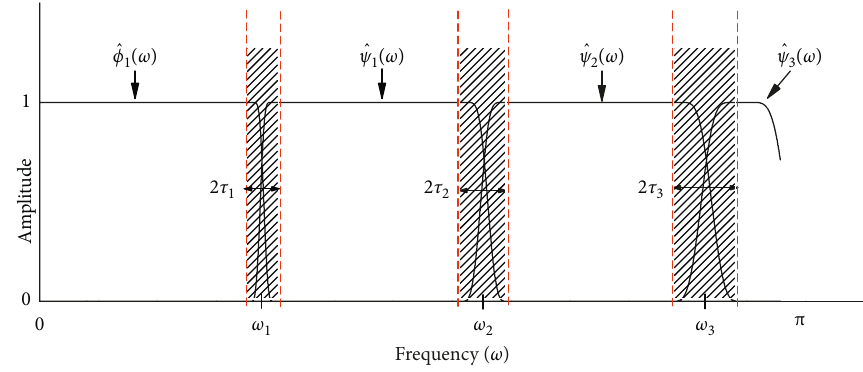
Figure 1: An empirical wavelet. Table 1: Parameters of the simulated